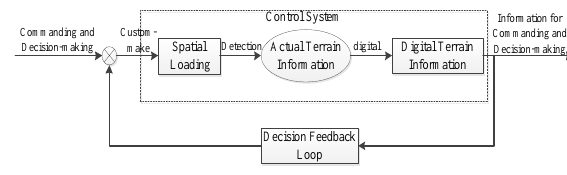
Figure 4. The closed-loop control system of spatial